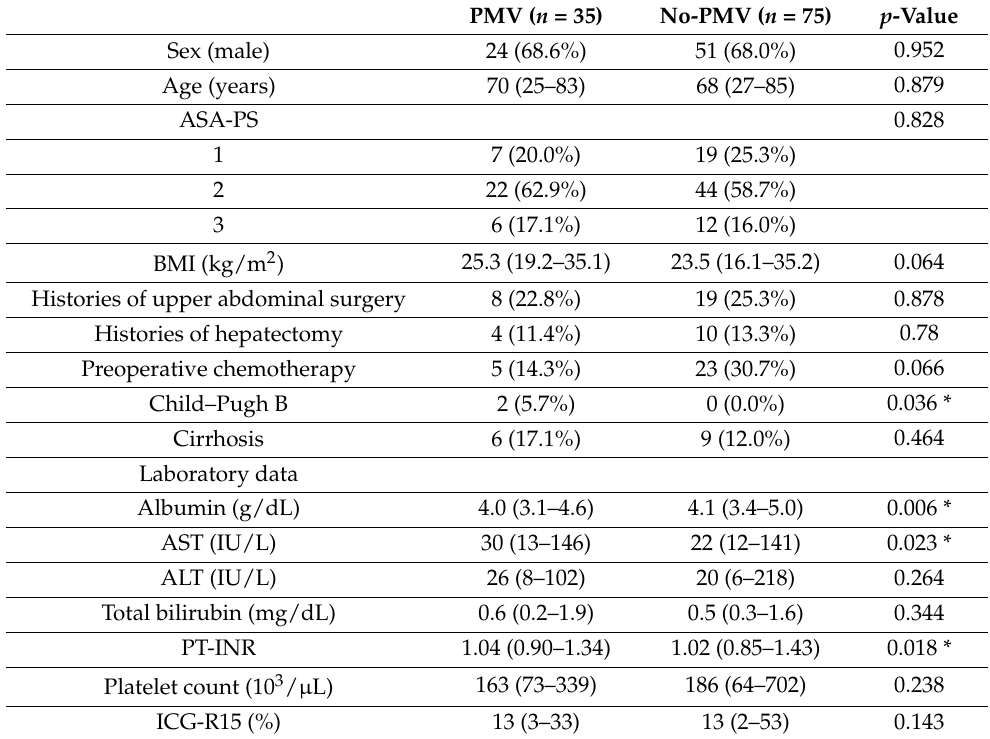
Table 3. Characteristics of patients that underwent laparoscopic PSH for lesions in PSS 7 and 8.